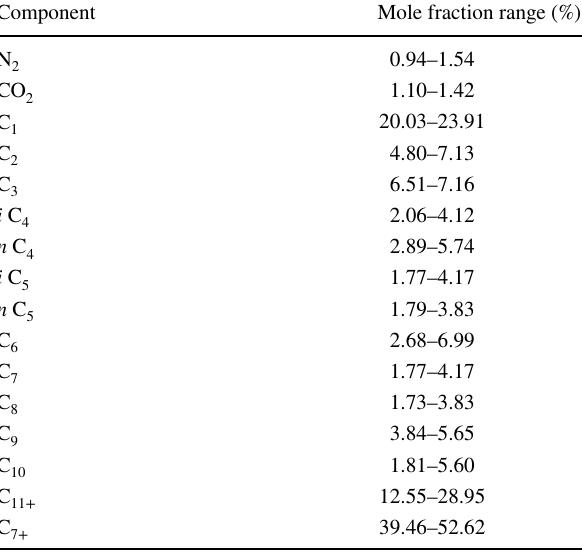
Table 6 Composition of the reservoir fluid Component Mole fraction range (%)